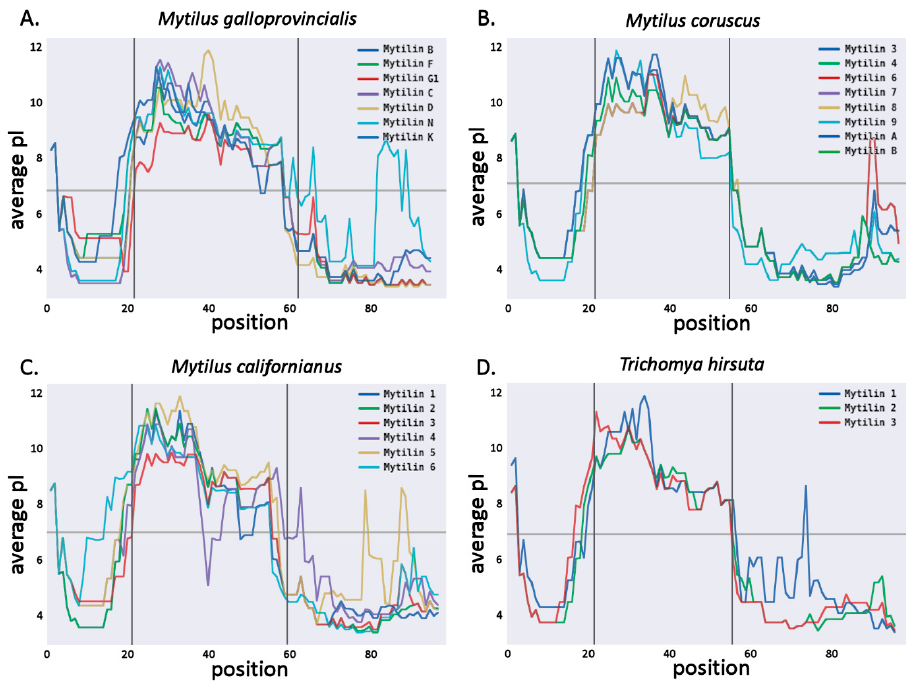
Figure 4. Average isoelectric point, calculated based on a sliding window of 15 aa for M. galloprovncialis ( panel A ), M. coruscus ( panel B ), M. californianus ( panel C ) and T. hirsuta ( panel D ) mytilins. The vertical bars indicate the division between the signal peptide, mature peptide and C-terminal extension regions (see Figure 3).